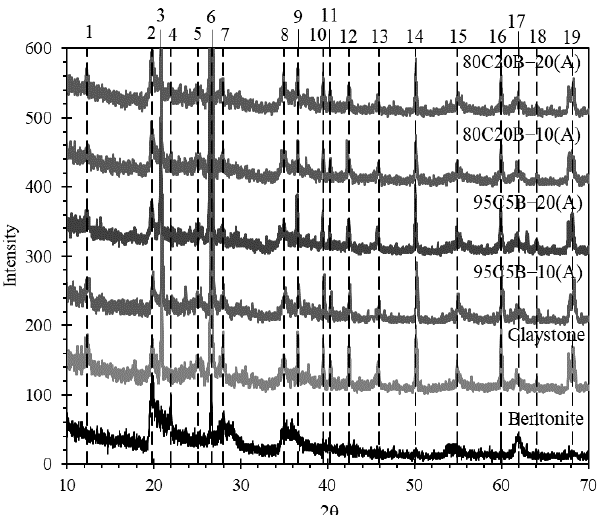
Fig. 2. Mineralogy of samples before and after tested by the acidic